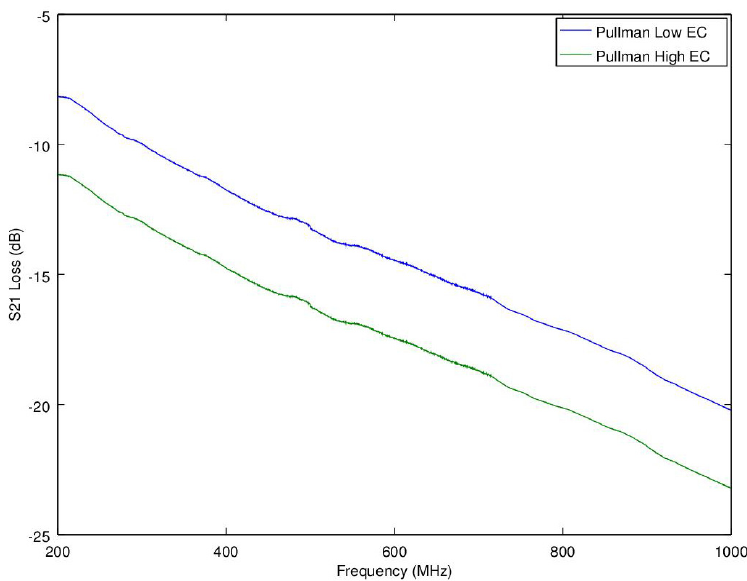
Figure 7. This is a chart of measurement results utilizing the new probe design with column filled with a saturated Pullman clay loam at low and high EC. The measurement is of the through transmission loss (S21) for Pullman clay loam. Of importance is the dramatic increase in loss when the salinity content increases. This fact is what leads time ‐ domain reflectometry (TDR) measurements to be severely band ‐ limited, thereby predicting Ka at only much lower frequencies where salts have the greatest impact on accuracy. It also creates a different measurement frequency for TDR dependent upon the saline content.